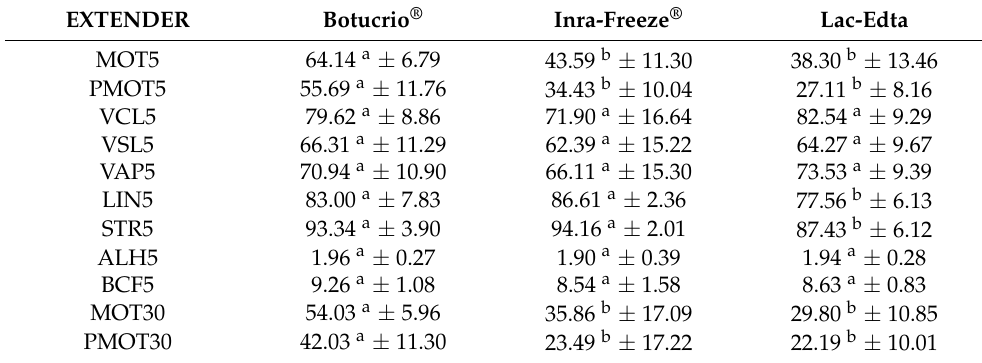
Table 4. Motility parameters 5 and 30 min after thawing for freezing extenders in AACC group. EXTENDER Botucrio ® Inra-Freeze ®